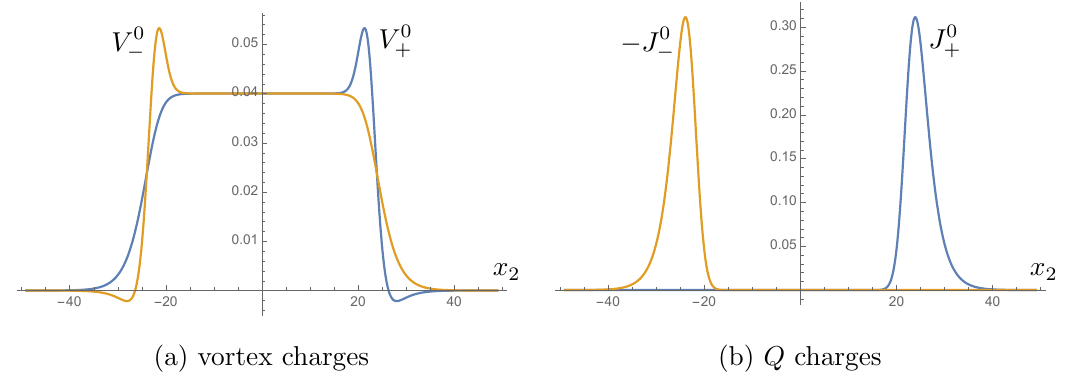
Figure 6 . Vortex and Noether charge densities with d = 50, ~ d = 1 = 10, m = (cid:25) , (cid:24) = 1, ( !; k ) = (1 ; 1).